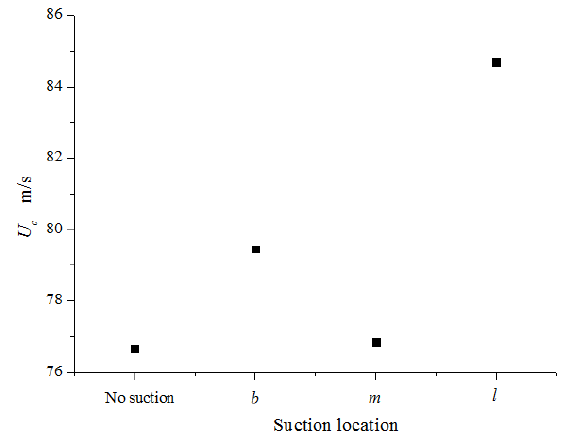
Figure 11. Flutter wind speed versus suction position.